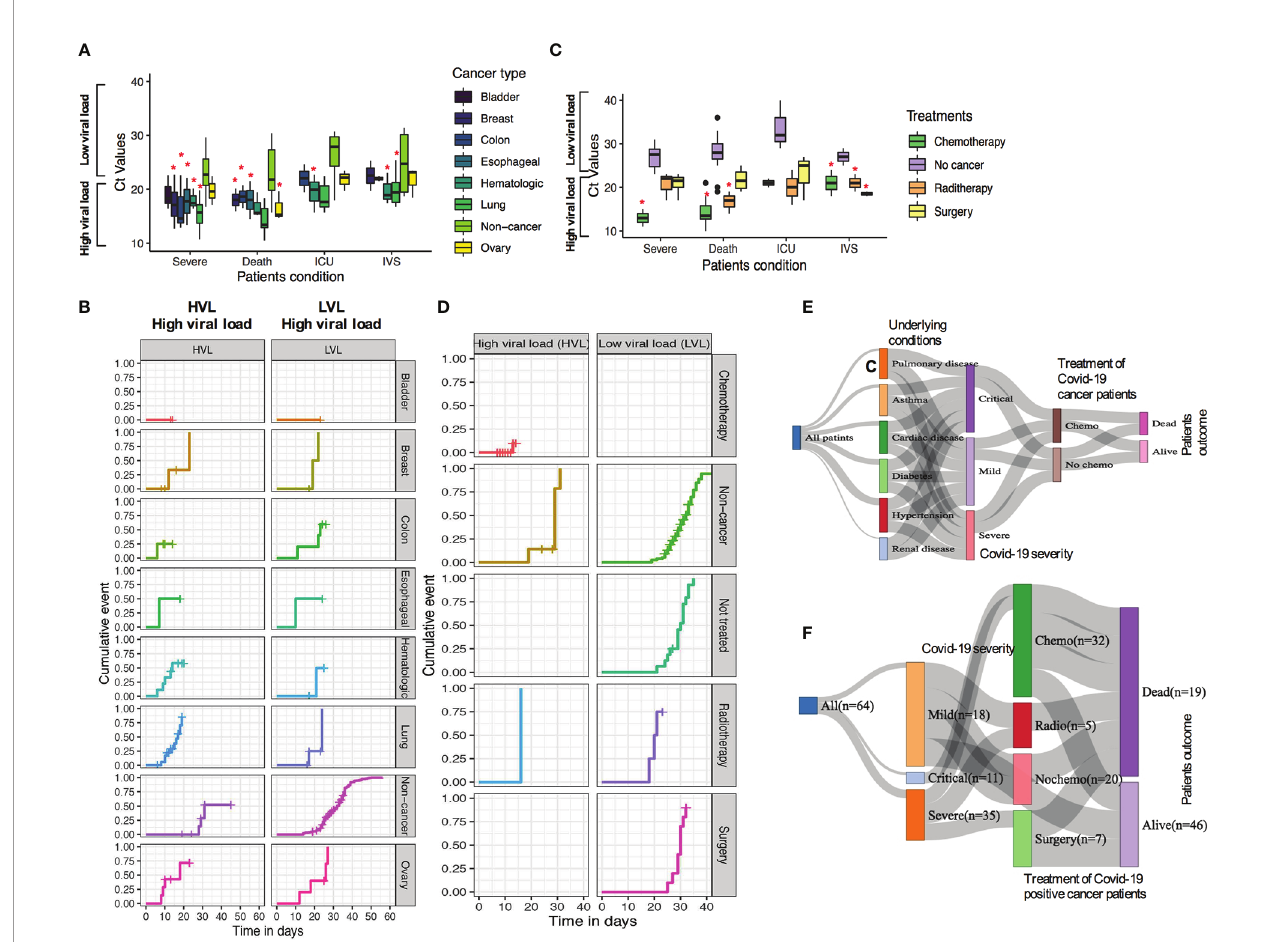
FIGURE 5 | (A, B) SARS-CoV-2 Ct (cycle threshold) values in different type of cancer patients derived from nasopharyngeal swab test (C, D) . Relationship of chemotherapy use of con fi rmed Covid-19 cases and the mortality and severity of disease outcome. (E, F) Relationship of patients underlying condition, disease severity, and chemotherapy treatment and patient ’ s outcome. *P ≤